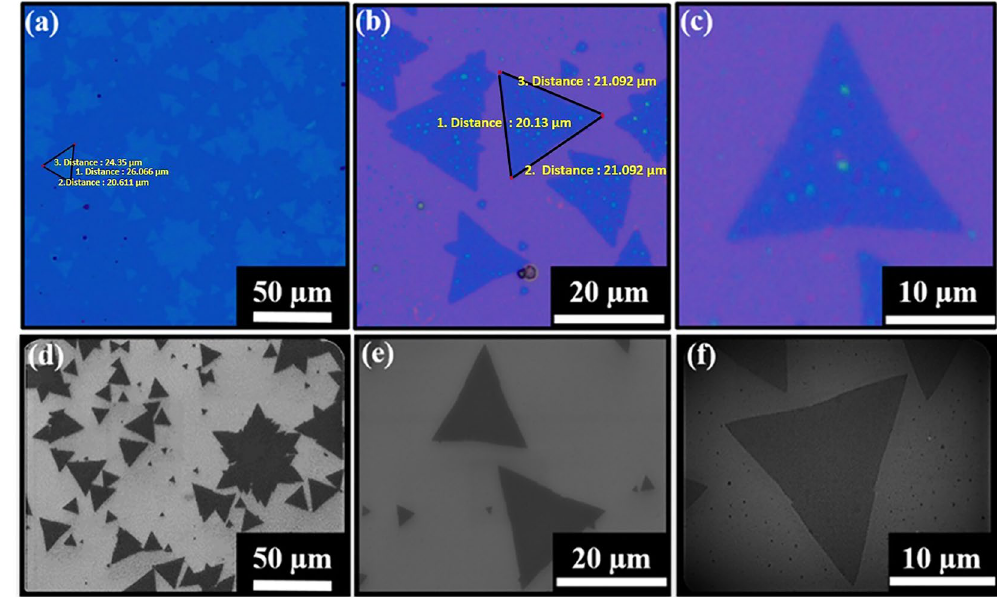
Figure 2. Optical and FESEM Characterizations. ( a–c ) Optical images. ( d–f ) FESEM images at different magnifications of APCVD grown monolayer MoS 2 over a 300 nm thick Si/SiO 2 substrate, scale bar is